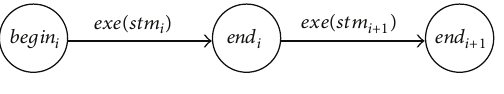
Figure 8: Sequence instruction translation rule. Figure 9: Branch instruction translation rule.